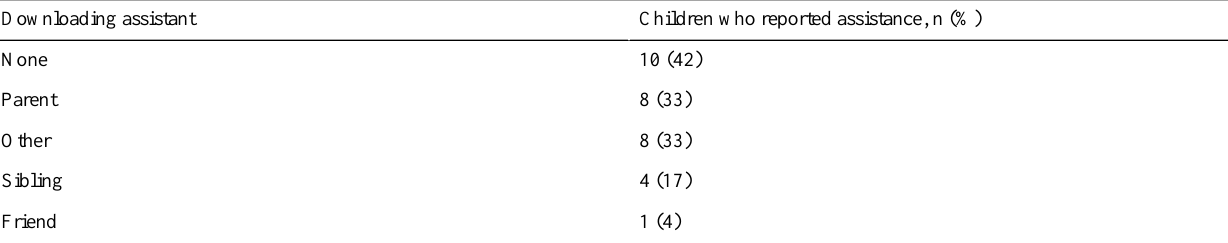
Table 3. Children’s reported downloading assistance of social media apps (n=24).